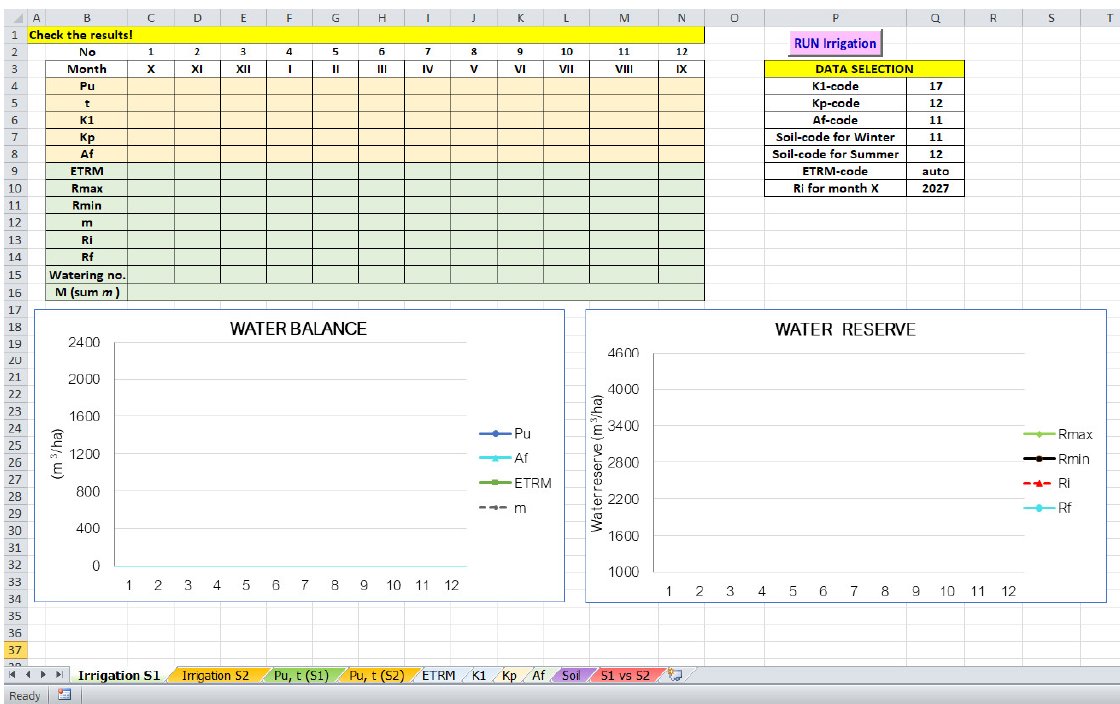
Figure 4. The “Irrigation S1”